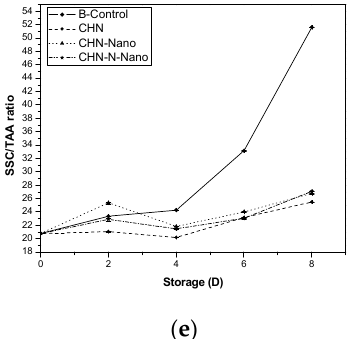
Figure 5. Biochemical components of coated blueberries pH ( a ), vitamin C ( b ), soluble sugar content ( c ), titratable acidity ( d ), and soluble sugar content/titratable acidity (SSC/TAA) ratio ( e ) under ambient temperature.